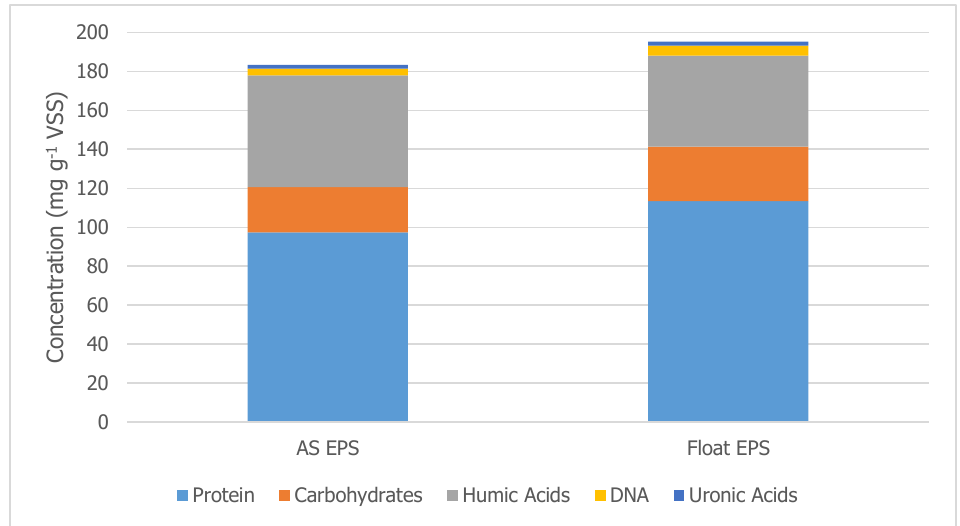
Figure 5. SMP Composition of Raw Wastewater and DAF Underflow (Effluent).